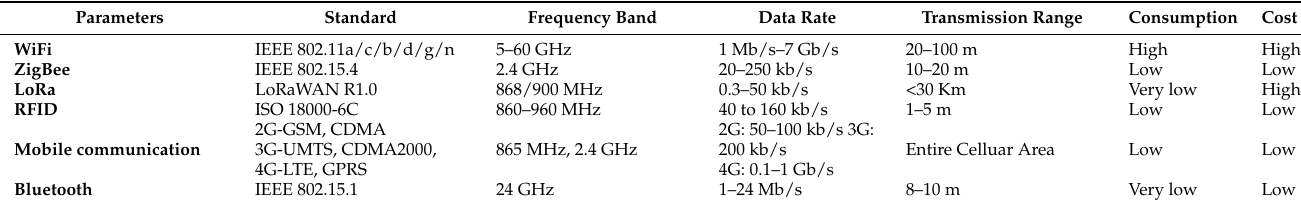
Figure 9. Wireless Sensor Network (WSN). Table 6. Wireless communication technologies. Table 6. Wireless communication